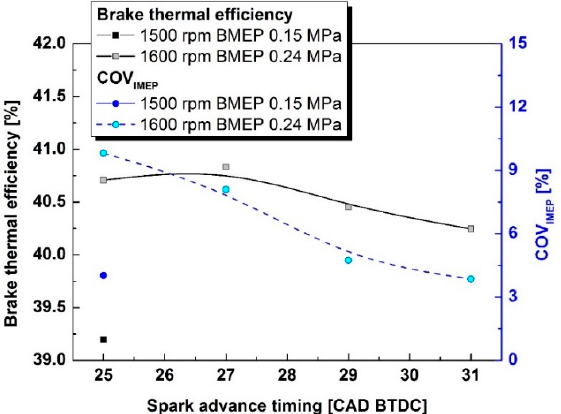
Figure 2. Variations in brake thermal efficiency and combustion stability with 27 and 19 CAD BTDC of fuel injection and 25 CAD BTDC of SA timing at an operation point of 1500 rpm and BMEP of 0.15 MPa, and